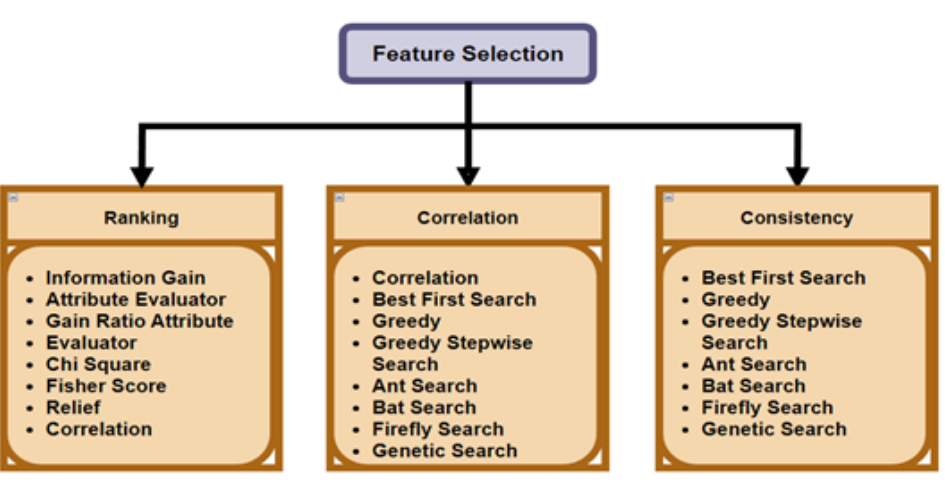
Figure 4. Feature Selection Search Methods Hà et al. [27].